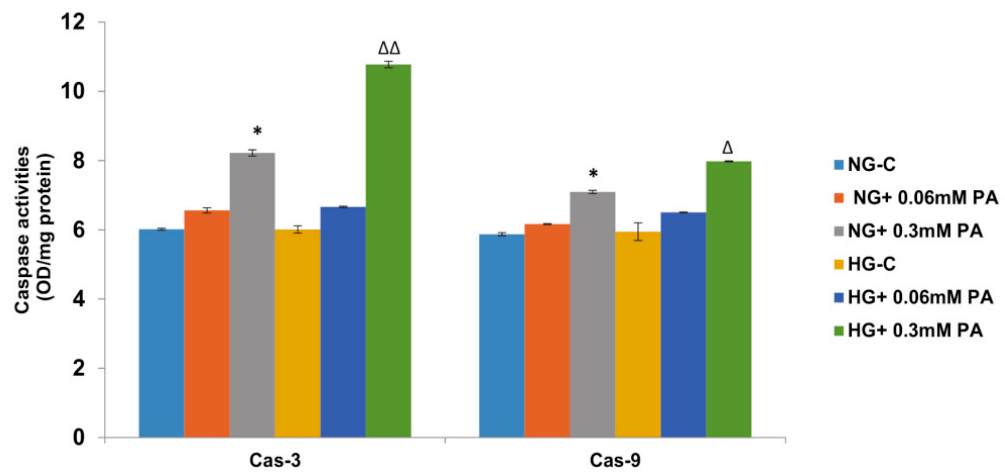
Figure 2. High glucose/high palmitic acid increased the activities of caspase-3 (Cas-3) and -9 (Cas-9). Activities of caspases were measured in treated cells colorimetrically using the respective substrates as described in the Materials and Methods section. Results are expressed as mean +/ − SEM of three experiments. Asterisks indicate significant differences (* p ≤ 0.05) relative to untreated control cells under normal glucose condition (NG-C), and triangles indicate significant differences ( Δ p ≤ 0.05, ΔΔ p ≤ 0.01) relative to untreated control cells under high glucose condition (HG-C).